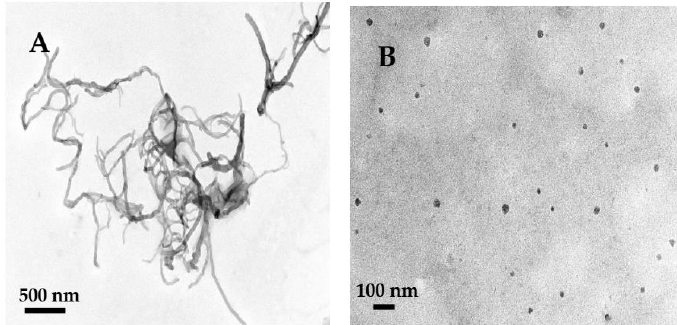
Figure 2. TEM images of MWCNTs ( A ), HFs ( B ).